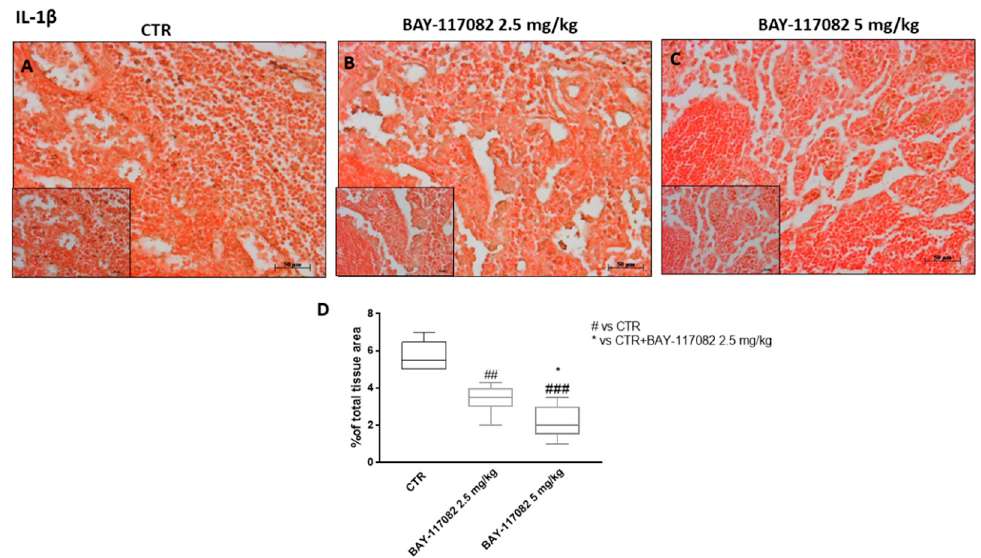
Figure 9. Effect of BAY-117082 on IL-1 β expression in CAL27 xenograft model. Immunohistochemistry assay revealed that ( A ) control group was characterized by high IL-1 β expression, and ( B , C ) treatment with BAY-117082 at doses of 2.5 and 5 mg/kg significantly reduced its expression. Data are representative of at least three independent experiments. Sections were observed and photographed at 20 × and 40 × magnification. ( D ) ## p < 0.01 vs. CTR; ### p < 0.001 vs. CTR; * p < 0.05 vs. CTR + BAY-117082 2.5 mg/kg.